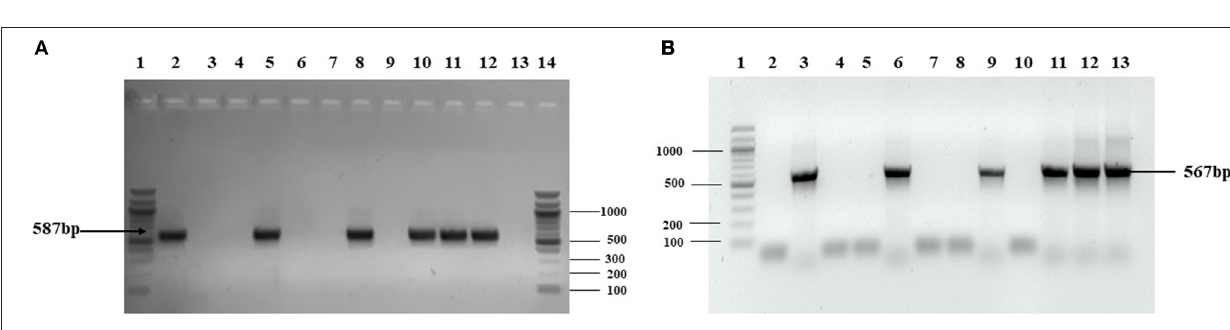
FIGURE 4 | PCR analysis of putative transgenic maize plants. Genomic DNA extracted from transgenic leaves and corn seeds was used as template for amplification. Amplification from putative maize plants transformed by agrobacterium mediated transformation. (A) PCR was carried with gene specific for F gene and amplified 587 bp product size confirmed the presence of F gene in five plants out of ten transformed plants (P1–P10). Lane 1 is 100bp ladder; Lane 2, positive control; Lane 3–12, PCR amplification from transformed plants (P1–P10) in which P3, P6, P8, P9, and P10 confirmed the presence of F gene in maize leaves; Lane 13, PCR amplification from non-transgenic plant; Lane 14, 100bp ladder. (B) PCR was carried with gene specific for HN gene and amplified 567 bp product size confirmed the presence of HN gene in five plants out of 10 transformed plants. Lane 1, 1kb ladder; Lane 2, the PCR from non-transgenic plant; Lane 3, positive control; Lane 4–13, PCR amplification from transformed plants (P1–P10) in which P3, P6, P8, P9, and P10 confirmed the presence of HN gene in maize